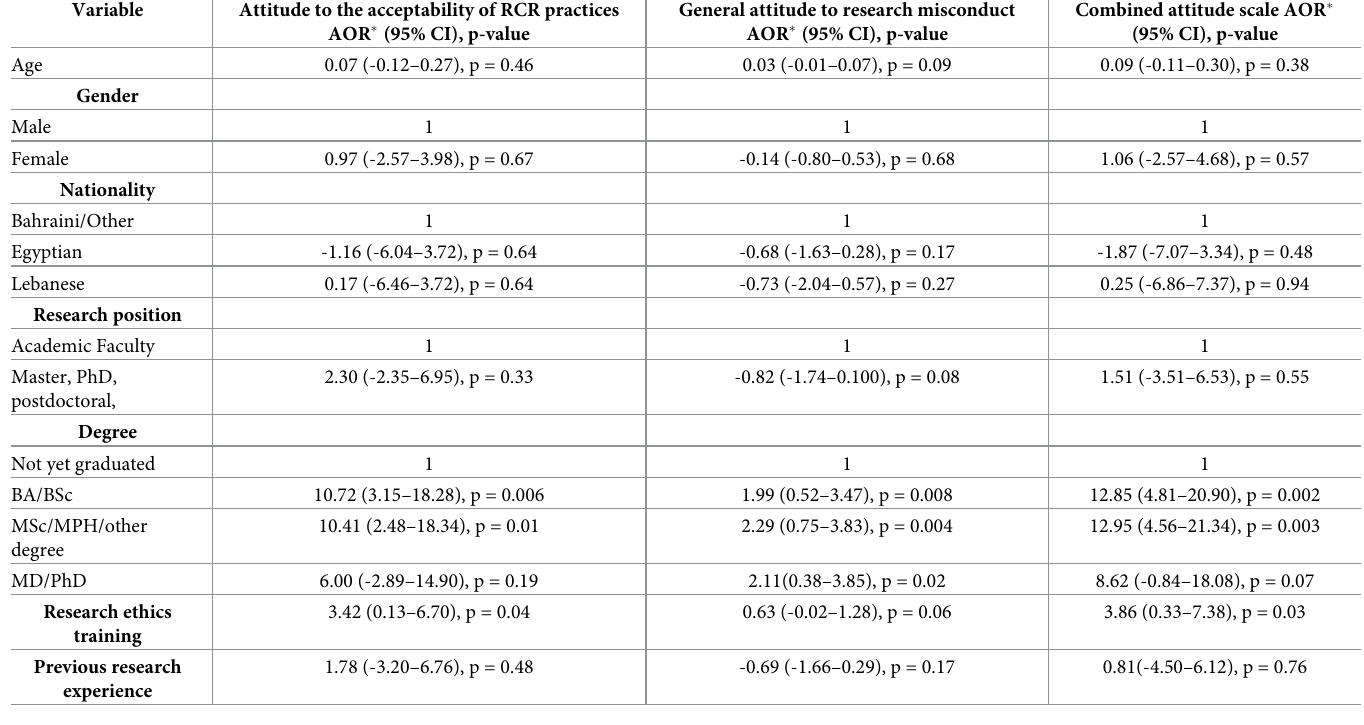
Table 6. Predictors of the attitude scales (“attitudes toward the acceptability of RCR practices”, “general attitudes toward research misconduct”, and the “combined attitude scale”). Variable